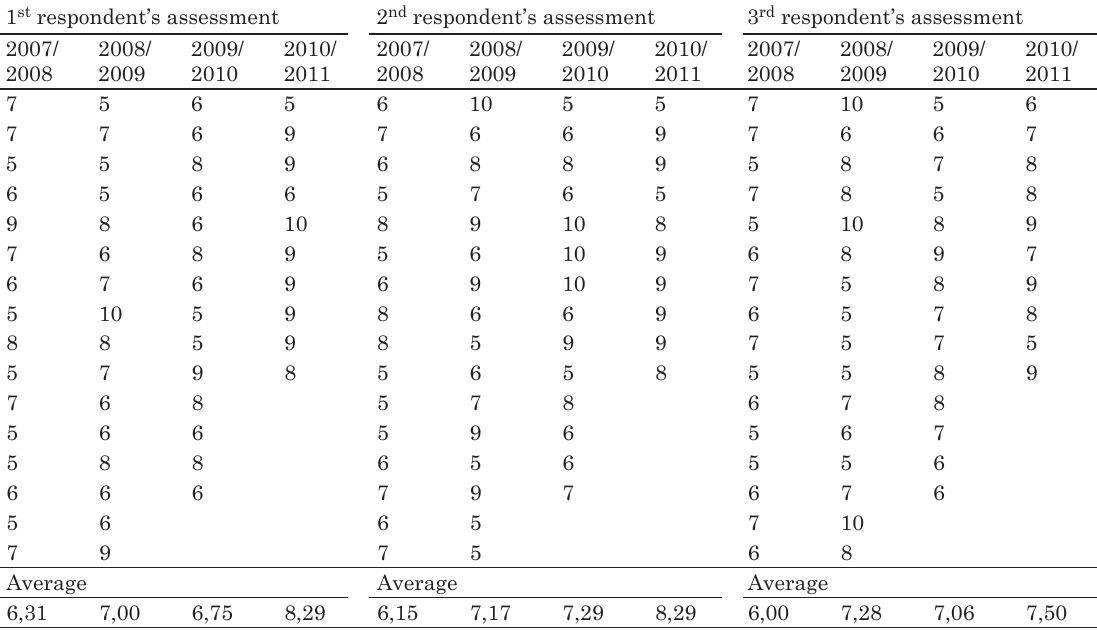
Table 1. The grades of three respondents (as example from 114 respondents) and the scores given to the degree of interest by each subject in each academic year (from 2007 till